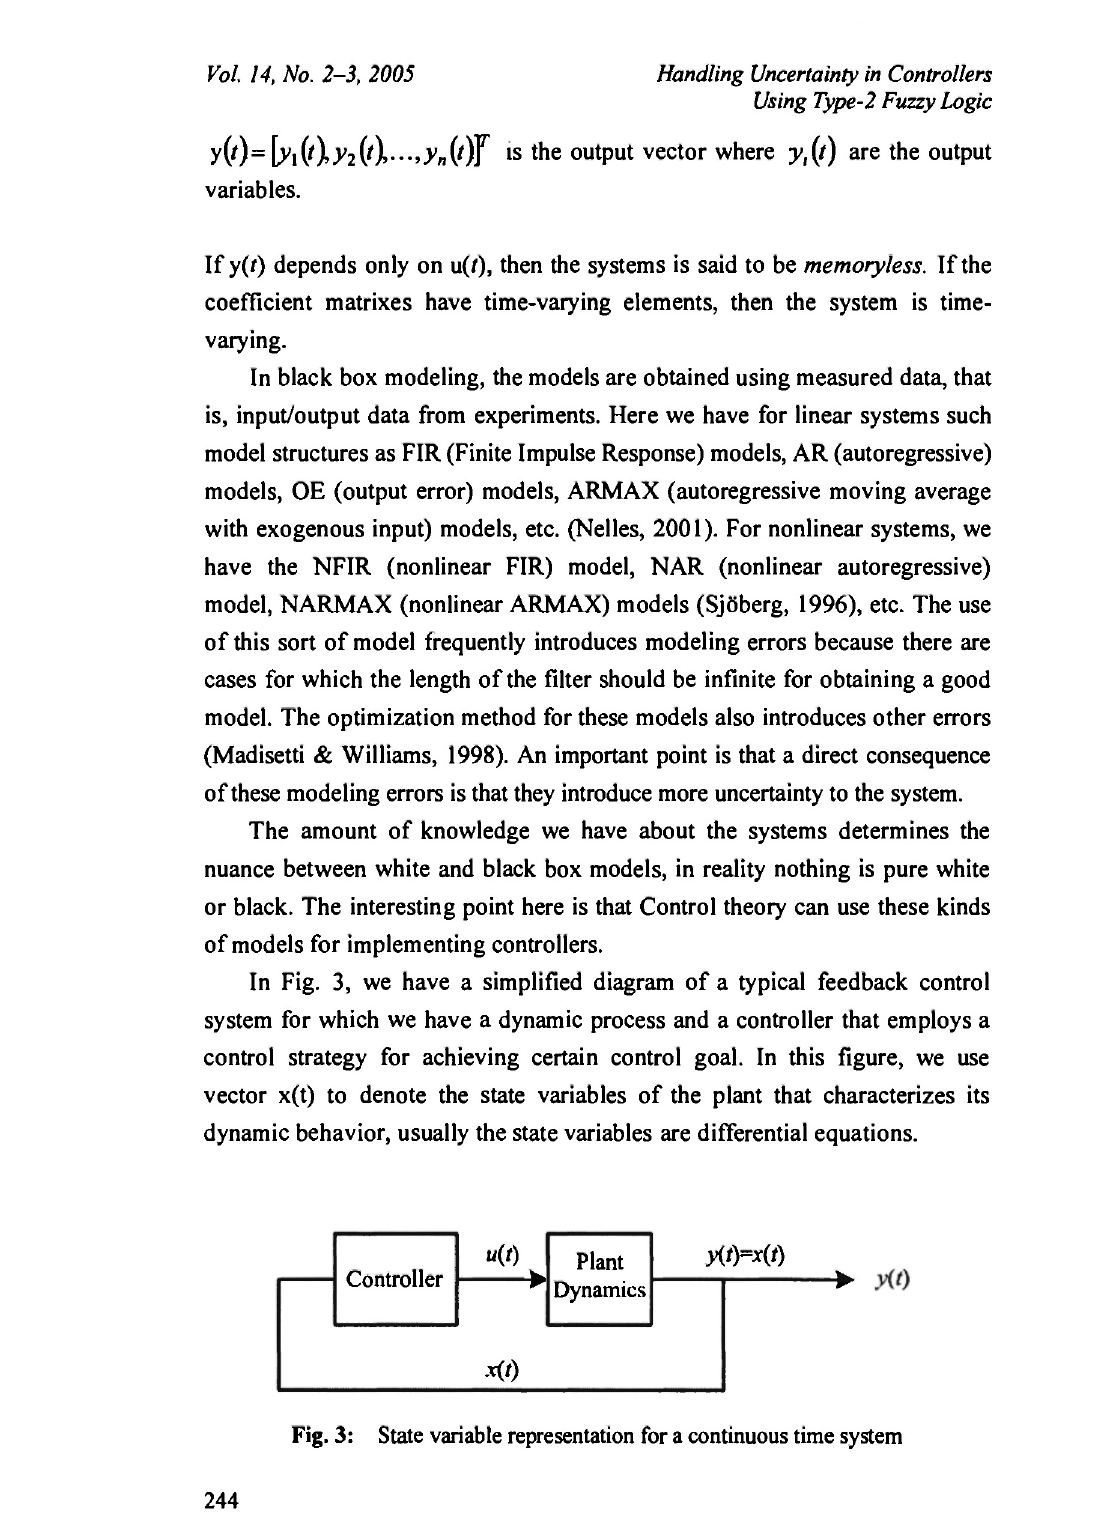
Fig. 3: State variable representation for a continuous time